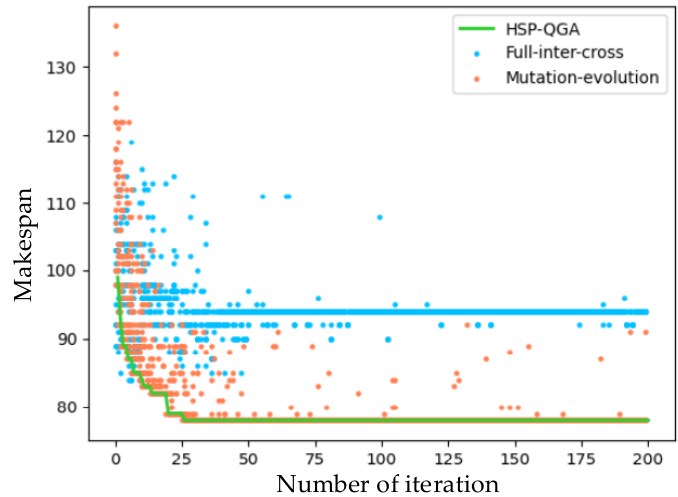
Figure 5. Scaer plot of the solution after full interference crossover operation.